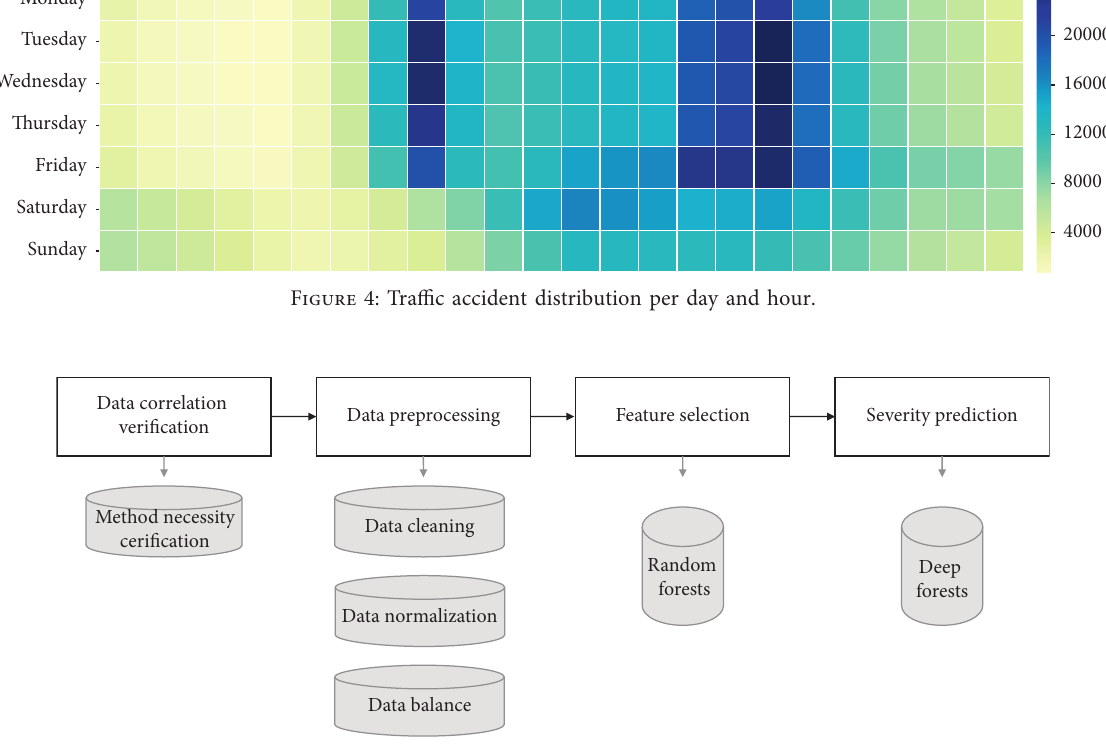
Figure 5: The flow diagram of traffic accident severity prediction method in this paper.